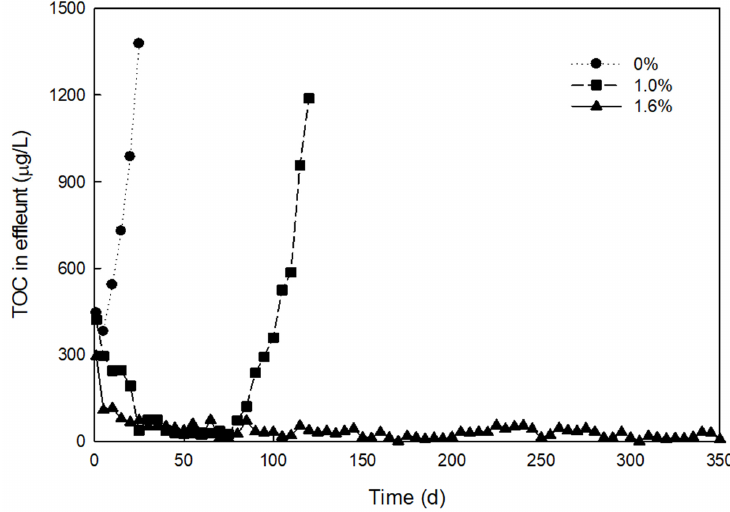
Figure 2. Concentration of TOC in eluents extracted from pellets prepared with different concentrations of crosslinker. of